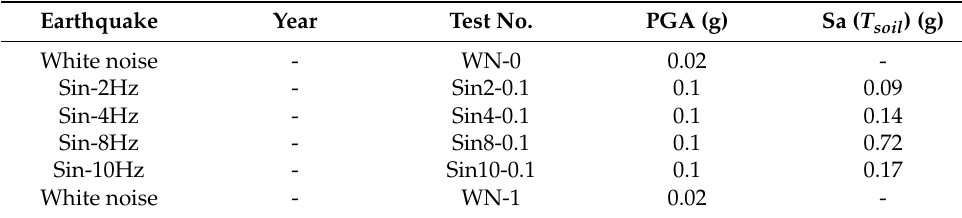
Table 4. Information and input sequence of the earthquake